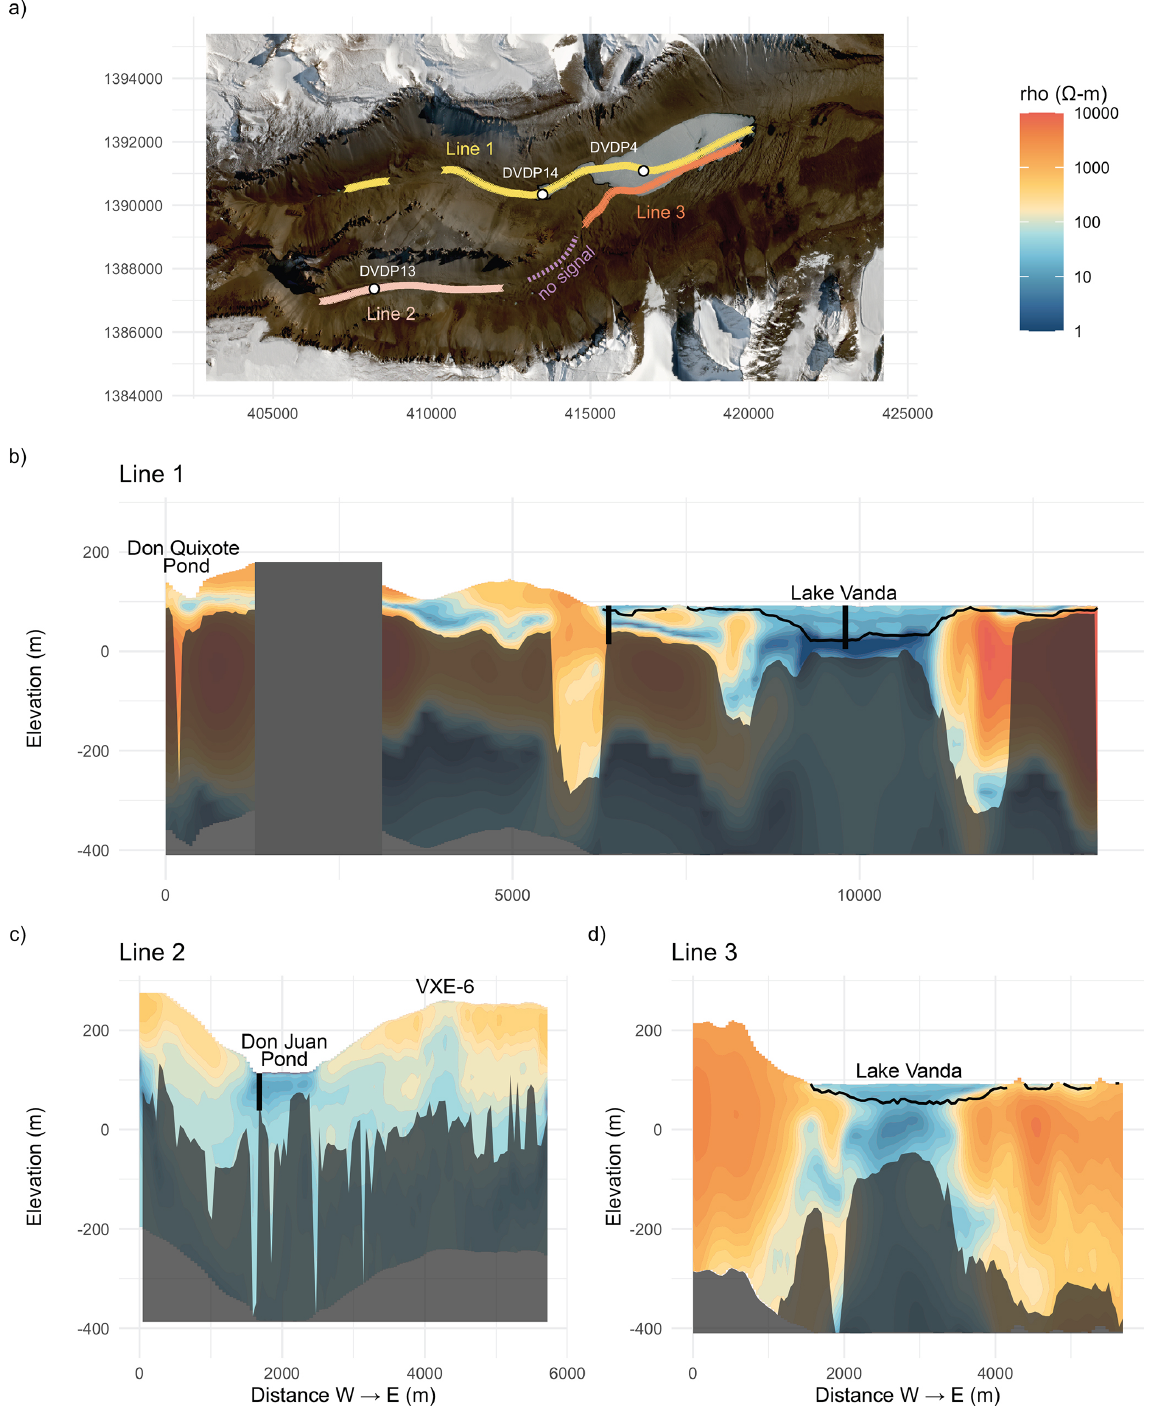
Figure 1. (a) AEM flight lines over the North Fork of Wright Valley and Lake Vanda (Line 1), over Don Juan Pond (Line 2), and over Lake Vanda towards the South Fork (Line 3). White circles show the locations of the DVDP boreholes. Coordinates are in UTM-58S. This contains modified Copernicus Sentinel data 2020. (b–d) Resistivity profiles of the three flight lines. The black line represents the sediment– water interface (bathymetry) of the Lake Vanda basin. Lower data are shaded beyond the depth of investigation. Black vertical rectangles show the approximate location and depth of the DVDP boreholes crossed by Lines 1 and